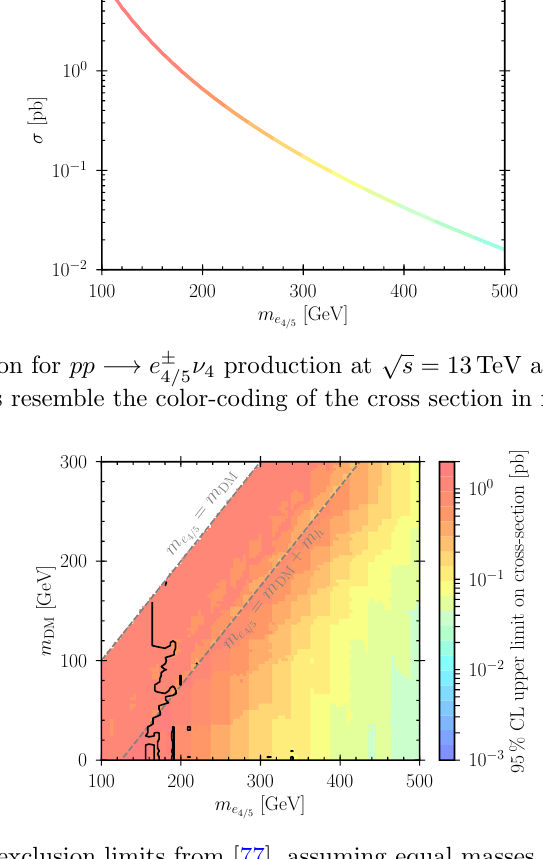
Figure 14 . CMS 95% exclusion limits from [77], assuming equal masses for all heavy leptons and that they decay within the